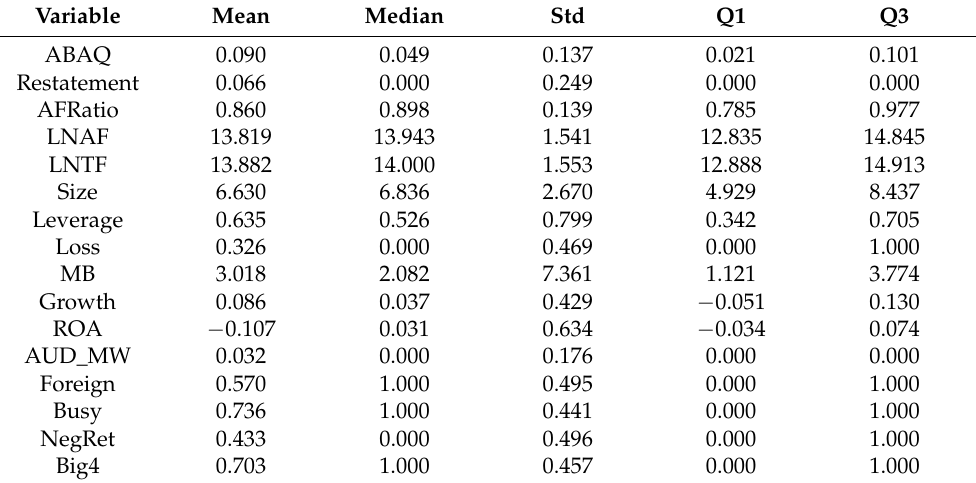
Panel E: Descriptive Statistics for the ABAQ, Restatement, and AF of U.S. sample firms in 3-year pre-Rule 3211 period.